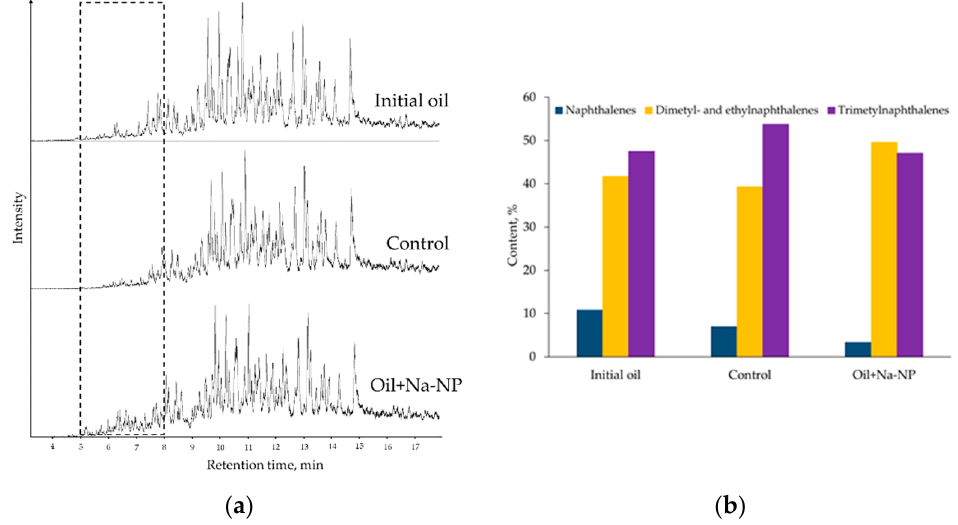
Figure 8. GC-MS spectra of ( a ) naphthalenes before and after processing, and ( b ) the relative content of them in the composition of aromatics fractions